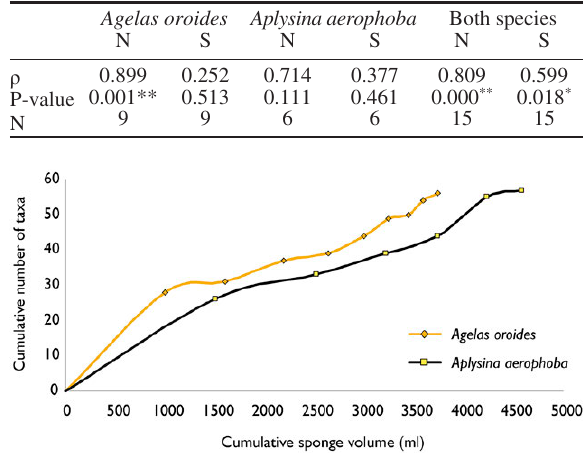
Fig. 3. – Cumulative curves of number of taxa per sponge volume for Agelas oroides and Aplysina aerophoba .